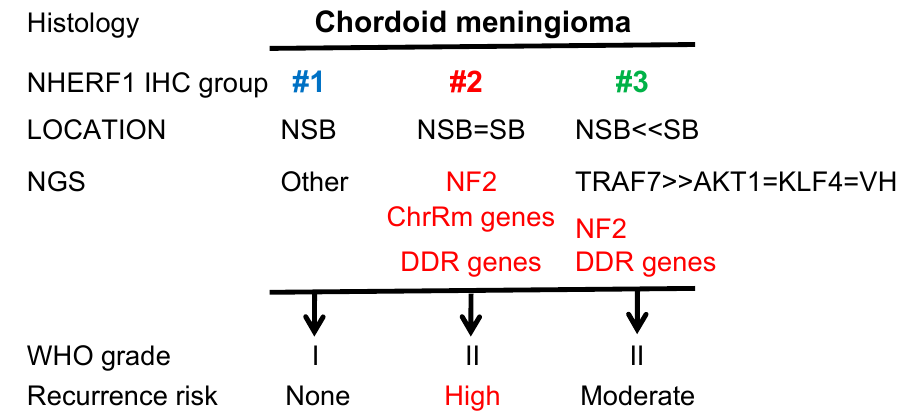
Figure 5. Flow chart illustrating the step-wise analysis of chordoid meningioma and the proposed grading depending on the recurrence risk. ChrRm, chromatin remodeling; DDR, DNA damage response.